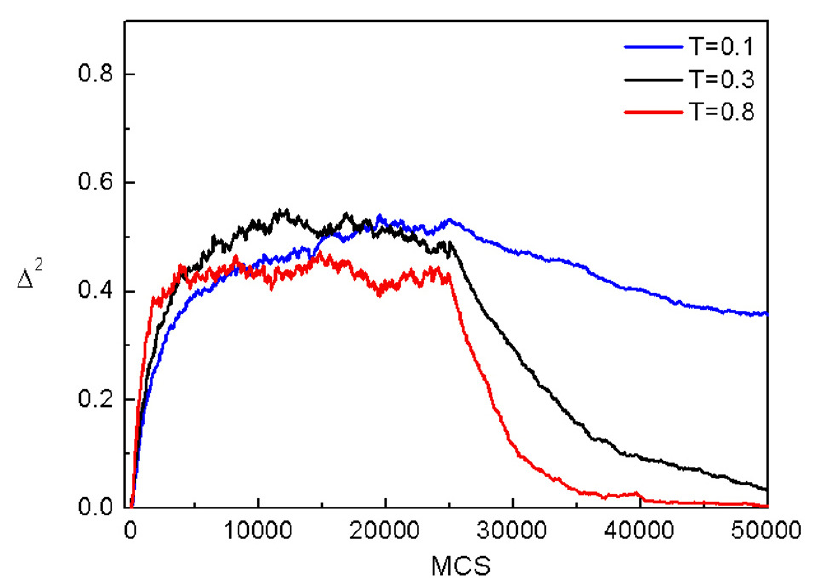
Figure 19. Typical MC-kinetics of diffraction efficiency ∆ 2 in the process of inscription and erasure of diffraction gratings.